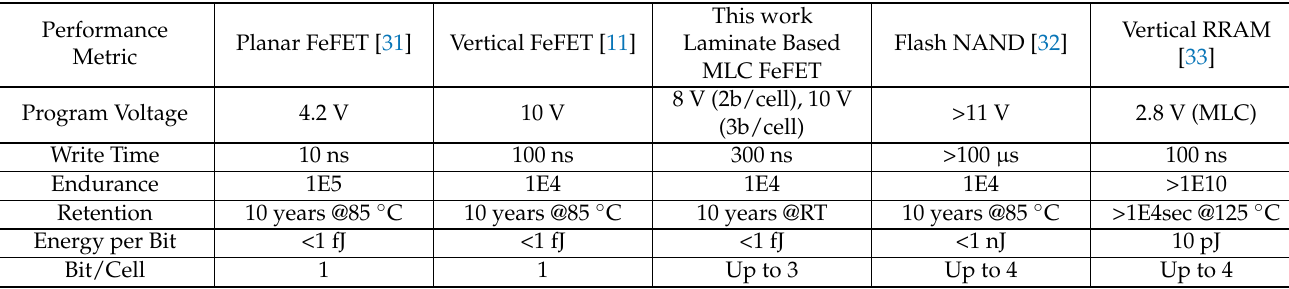
Table 1. Benchmark of the laminate based FeFET performance parameters with recent reports of the FeFET, Flash, and RRAM concepts, Reproduced with permission from [17] T. Ali et al., IEDM; published by IEEE, Copyright 2019,